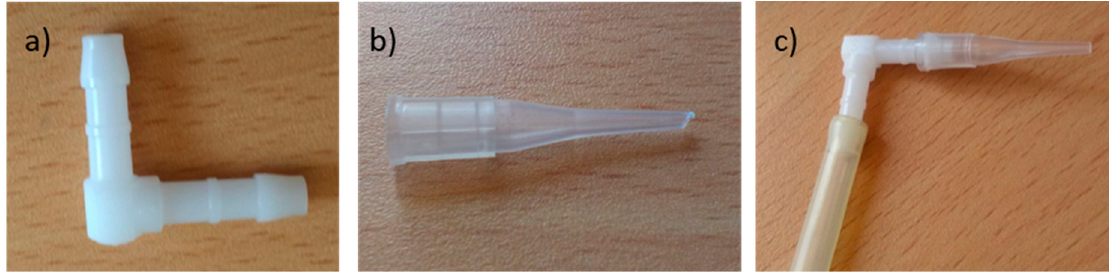
Figure 8. ( a ) Elbow connector, ( b ) cone-shaped connector, and ( c ) large section tube with both connectors.